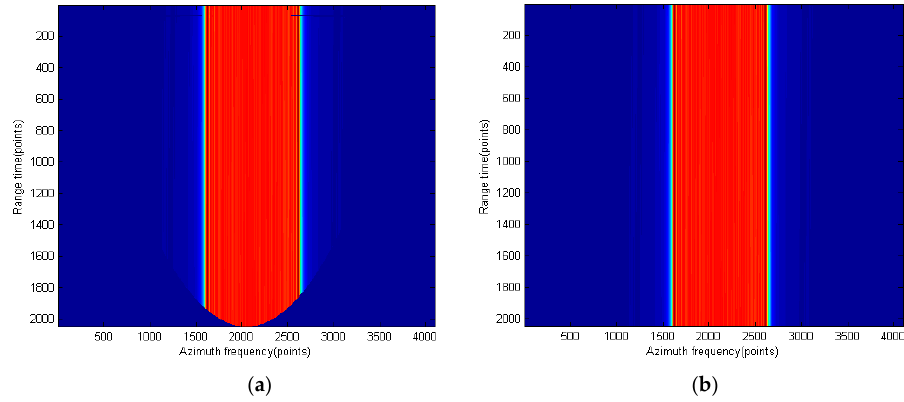
Figure 10. Range and azimuth slices of point C: ( a ) range slice and ( b ) azimuth slice.